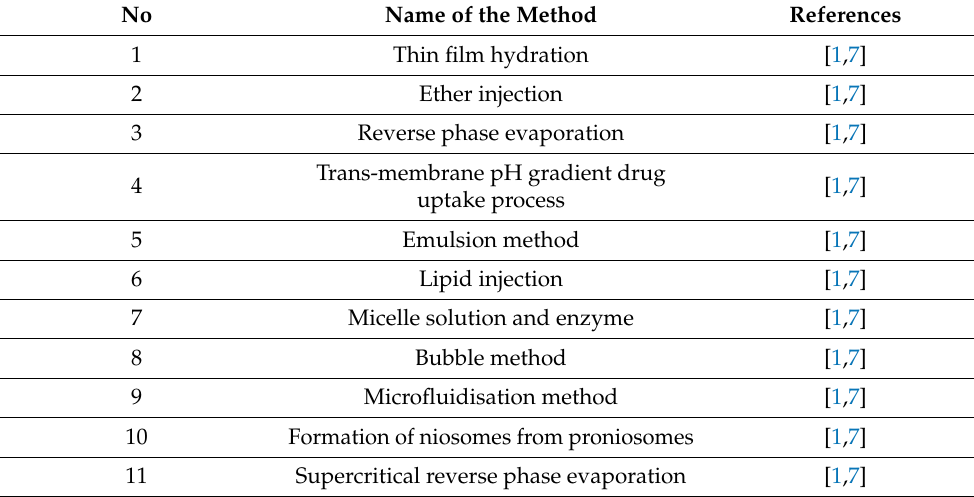
Table 4. Methods of niosomes